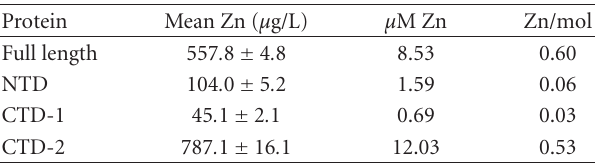
Table 2: ICP-MS analysis of zinc binding. Values shown are averages of triplicate samples of 250 μ g of the indicated protein in 500 μ L